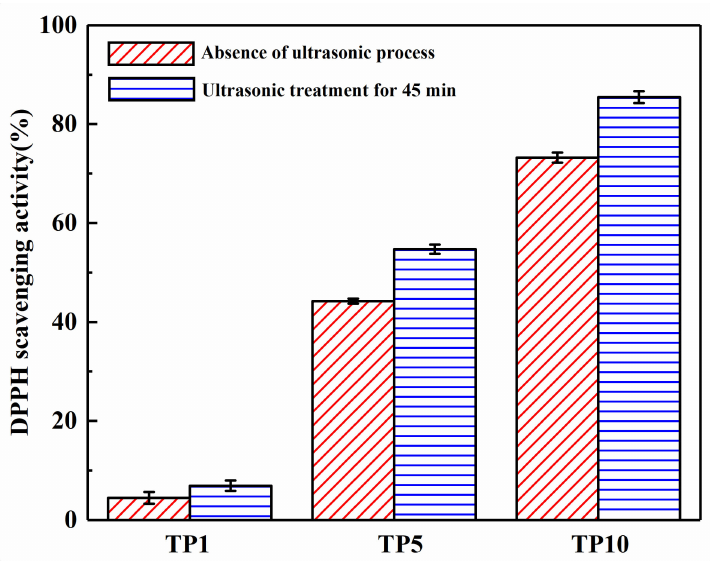
Figure 7. DPPH scavenging activity of samples with different TP content and ultrasound